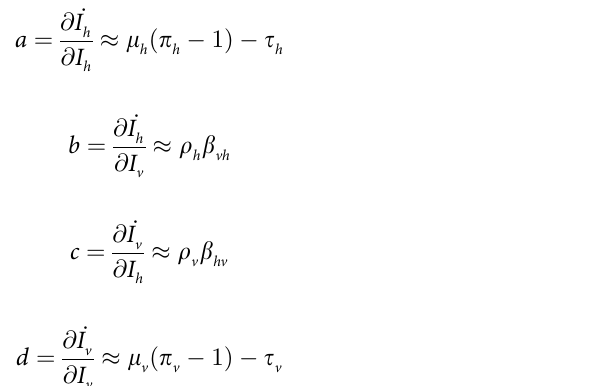
Linearising around the disease-free steady state, the components of the Jacobian matrix in eq 16 for this system can be calculated: